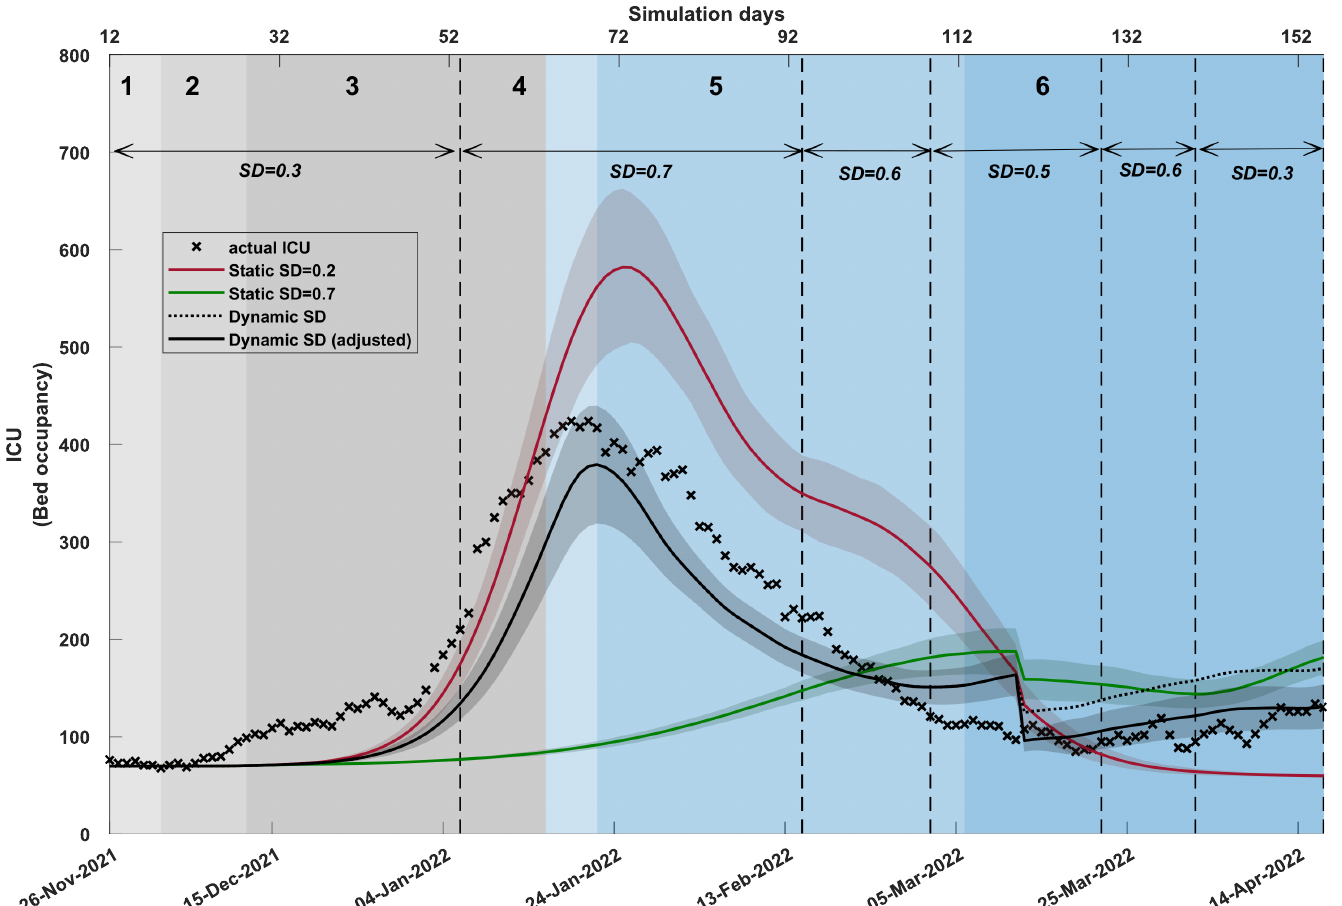
Fig 4. A comparison of ICU (bed occupancy) produced by different social distancing (SD) profiles. The plot contrasts (i) dynamic SD levels, adjusted for phase 6 by scaling with 0.77 to capture ICU cases due to COVID-19 (solid black), (ii) non-adjusted dynamic SD levels to represent all ICU cases (dotted black), and (iii) static SD levels ( SD 1 = 0.2, shown in red; SD 2 = 0.7, shown in green). The simulated ICUs are offset by 7 days. Coloured shaded areas around the solid line show standard deviation. Changes in dynamic SD-adoption are marked by vertical dashed black lines. Traces corresponding to each simulated scenario are computed as the average over 20 runs. SD adoption is combined with other interventions (i.e., school closures, case isolation, and home quarantine). The actual time series (black crosses), shown from 26th November 2021, aligns with the start of the Omicron outbreak in Australia. Shaded areas in grey and blue show the emergence of variants of concern and sub-lineages over time, identified in weekly genomic surveillance reports (NSW